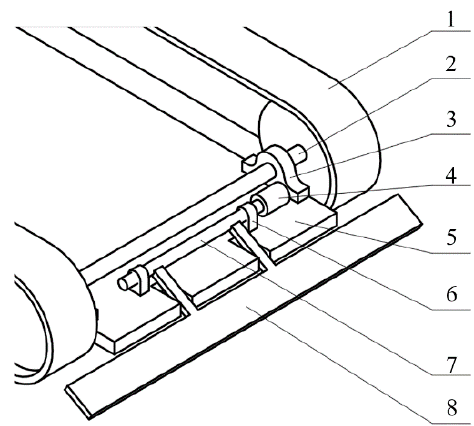
Figure 9. Structure of rust remover (1—track, 2—main shaft, 3—main pillow block, 4—small motor, 5—baseboard, 6—small pillow block, 7—small shaft, 8—plank).